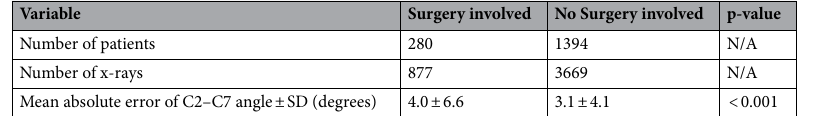
Table 6. Comparison of the errors between surgical and nonsurgical cases when measured by artificial intelligence. N/A, not applicable; SD, standard deviation.